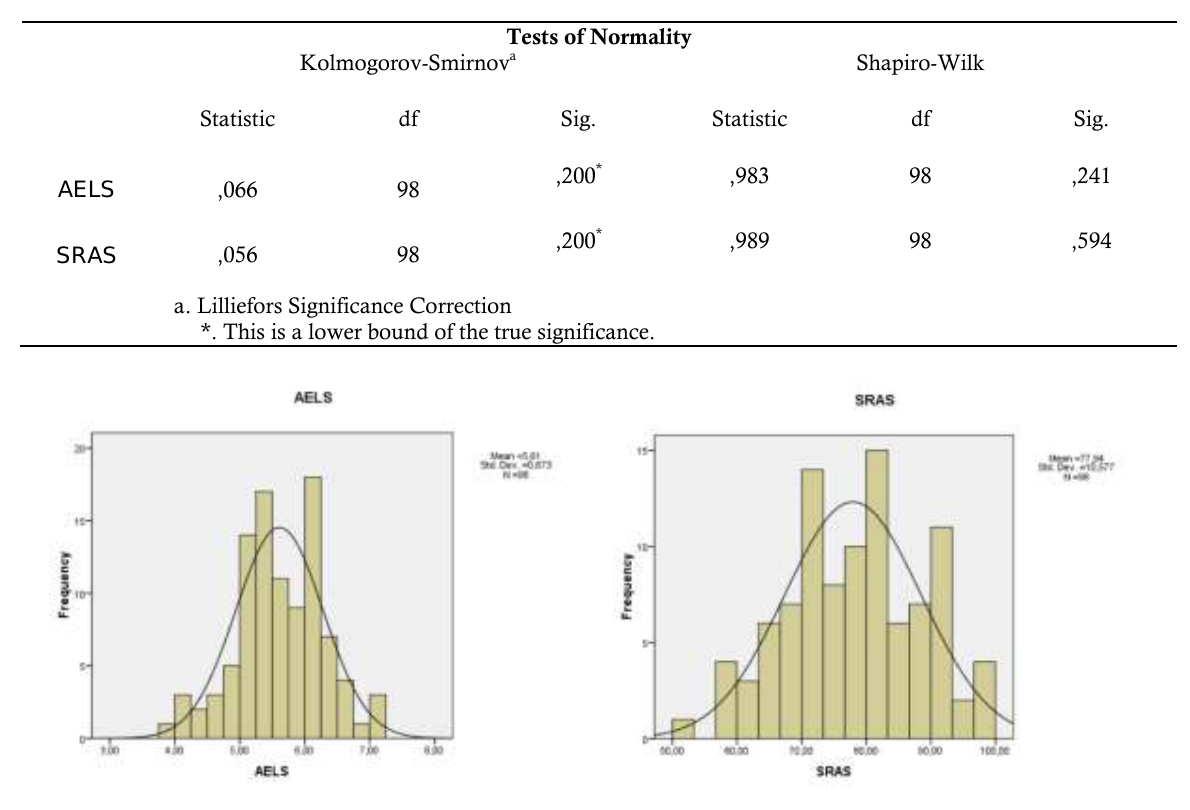
Figure 1. Frequency distribution of the two variables: AELS_TOT = Active- Empathic Listening Scale, SRAS_DR_TOT – Self-Reported Altruism